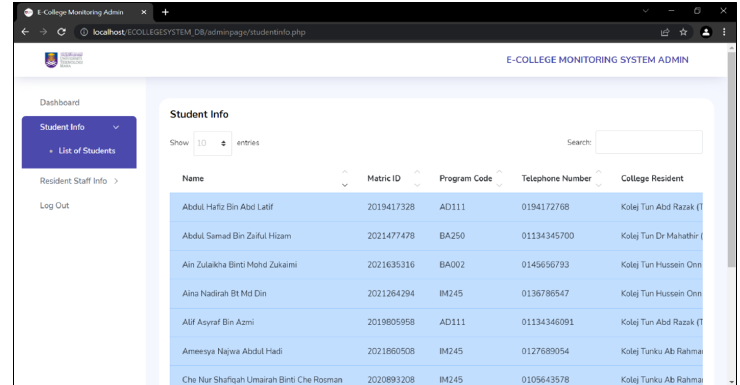
Figure 9. Students’ information page for the College Resident Staff (CSR).